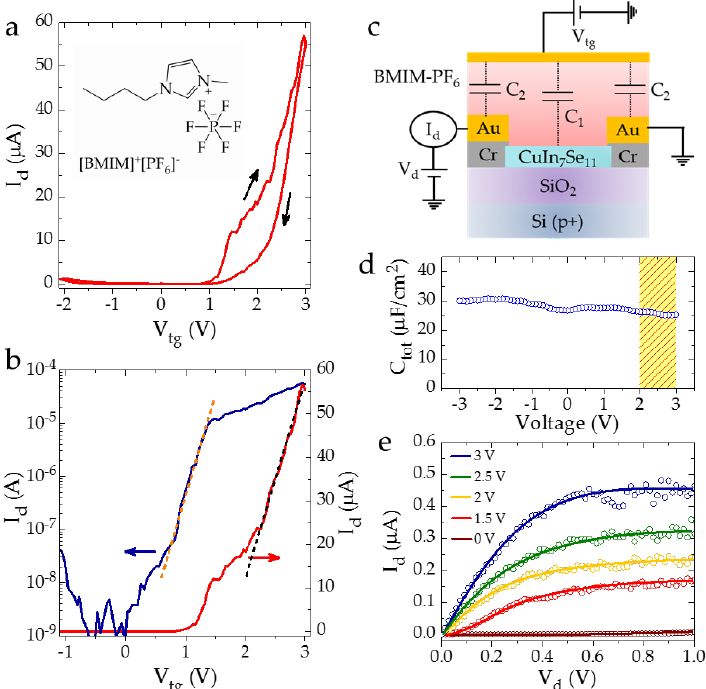
Figure 2. Electronic transport of CuIn 7 Se 11 FET with an electric double layer gate (Device I): ( a ) Transfer characteristics with an electric double layer gate for the forward cycle and the reverse cycle using the top gate. Inset: chemical structure of ionic liquid (BMIM-PF 6 ); ( b ) Transfer characteristics with an electric double layer gate for the forward cycle in the linear scale (red) and semi-log scale (blue); ( c ) A schematic of the EDL-FET and capacitances formed inside the ionic liquid; ( d ) Total capacitance, C tot , plotted as a function of applied voltage at 1 kHz frequency as estimated from Mott-Schottky analysis. The shaded area represents the values used for extracting the mobility; ( e ) Output characteristics under different top gate voltages (0 V ≤ V tg ≤ +3 V) are shown.